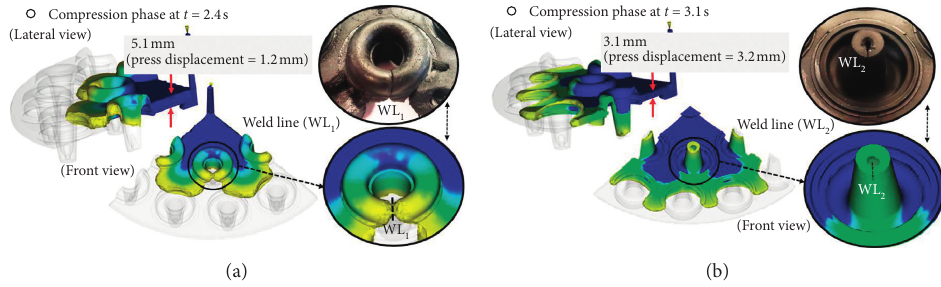
Figure 8: Results of the filling patterns obtained from simulation (Fill Time) and the corresponding incomplete molded part obtained through interrupted filling experiments during the compression phase. The initial press open distance is 1.2mm (a) and 3.2mm